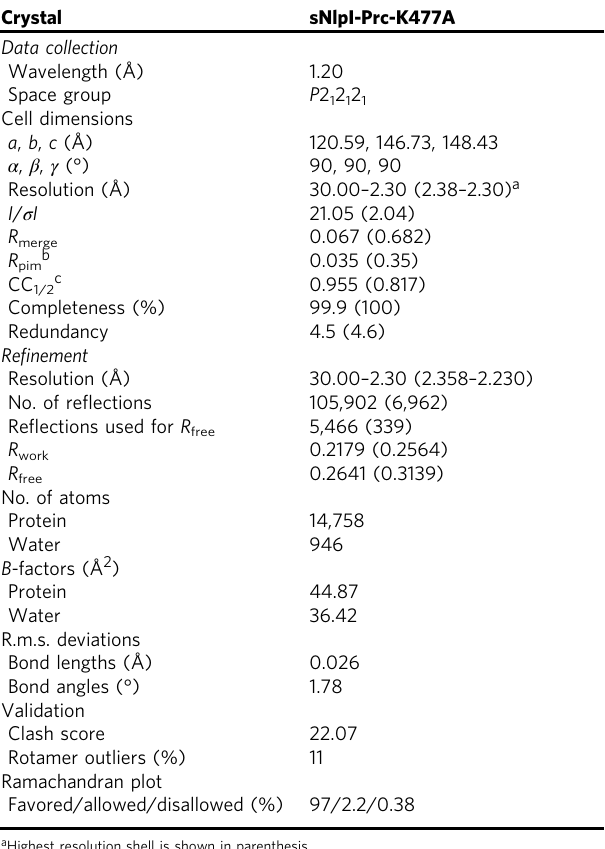
Table 1 Crystallographic data collection and re fi